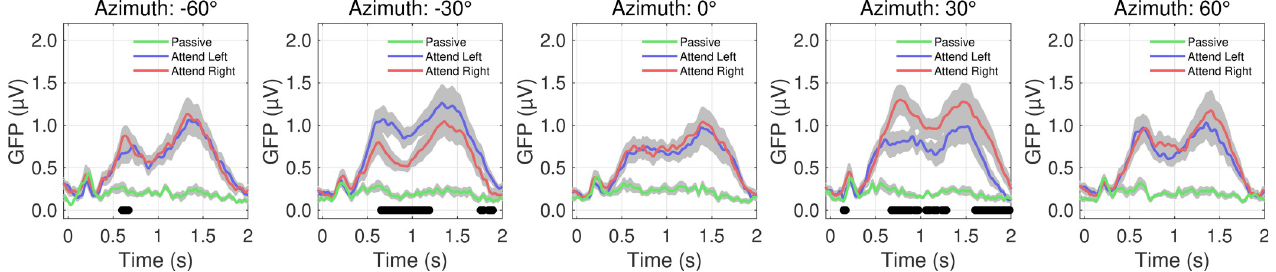
Fig 5. Grand average global field power (GFP) for stimuli presented in babble background for each attention condition (Passive [green]; Attend Left [blue]; Attend Right [red]). The five panels represent trials in which the target arrived at each of the five horizontal speaker locations (from left to right: -60˚ to +60˚). Grey shaded regions represent standard error of the mean, and black horizontal lines represent time latencies in which a significant difference was found between Attend Left and Attend Right conditions in a paired-samples t-test (alpha = 0.5; n = 18).